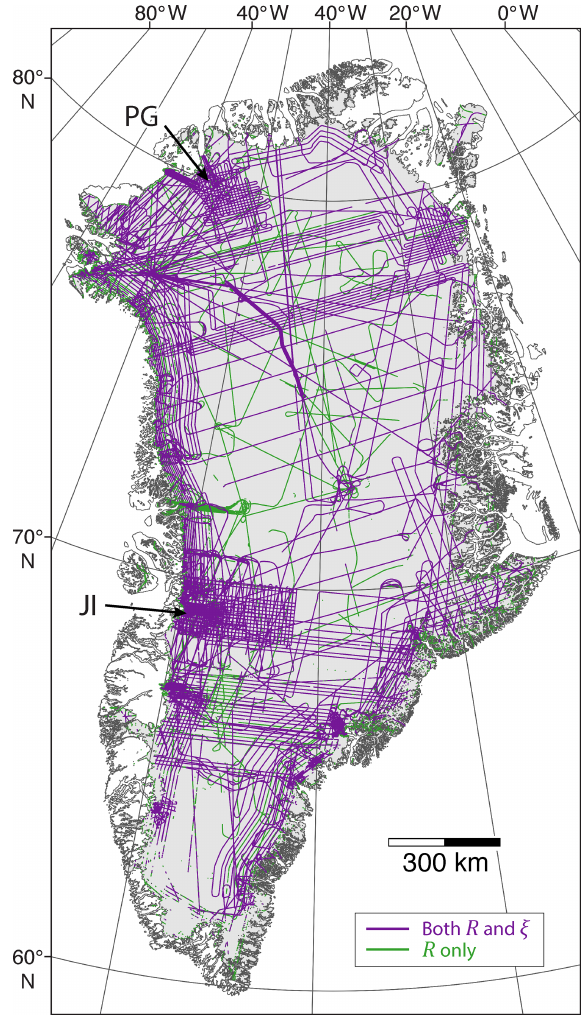
Figure 1. Coverage of radar sounding surveys over the GrIS used in this study. Topography-derived (topographic) roughness ( R ) is cal- culated using all available CReSIS survey data between 1993 and 2016, where scattering-derived roughness ( ξ ) uses only a subset of these (further explained in Sect. 2.3). JI and PG highlight the dense-grid sampling regime used over the Jakobshavn Isbræand Pe- termann Glacier catchments (as referred to in Sect. 3.1), displayed using a polar stereographic north projection (71 ◦ N, 39 ◦ W), as with all other spatial